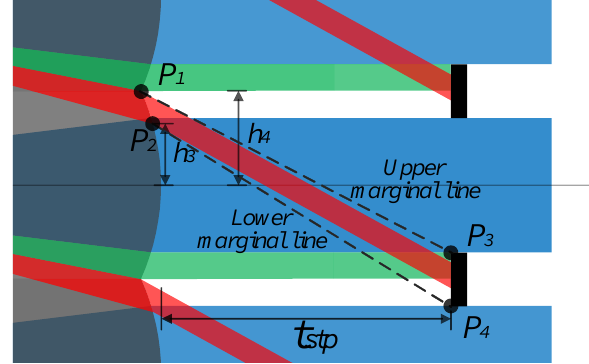
Figure 10. Specific schematic of the stray light suppression.